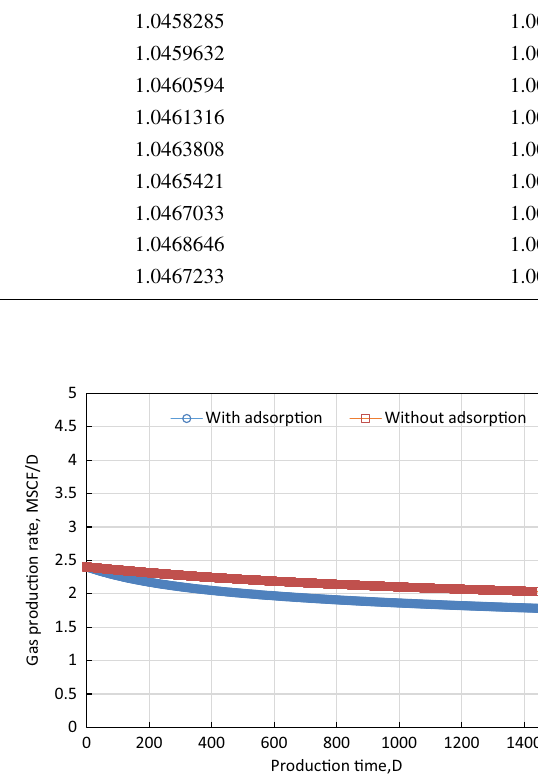
Fig. 2 Comparison shale gas production rate with respect different simulator Fig. 3 Effects of adsorption gas on the simulated gas production